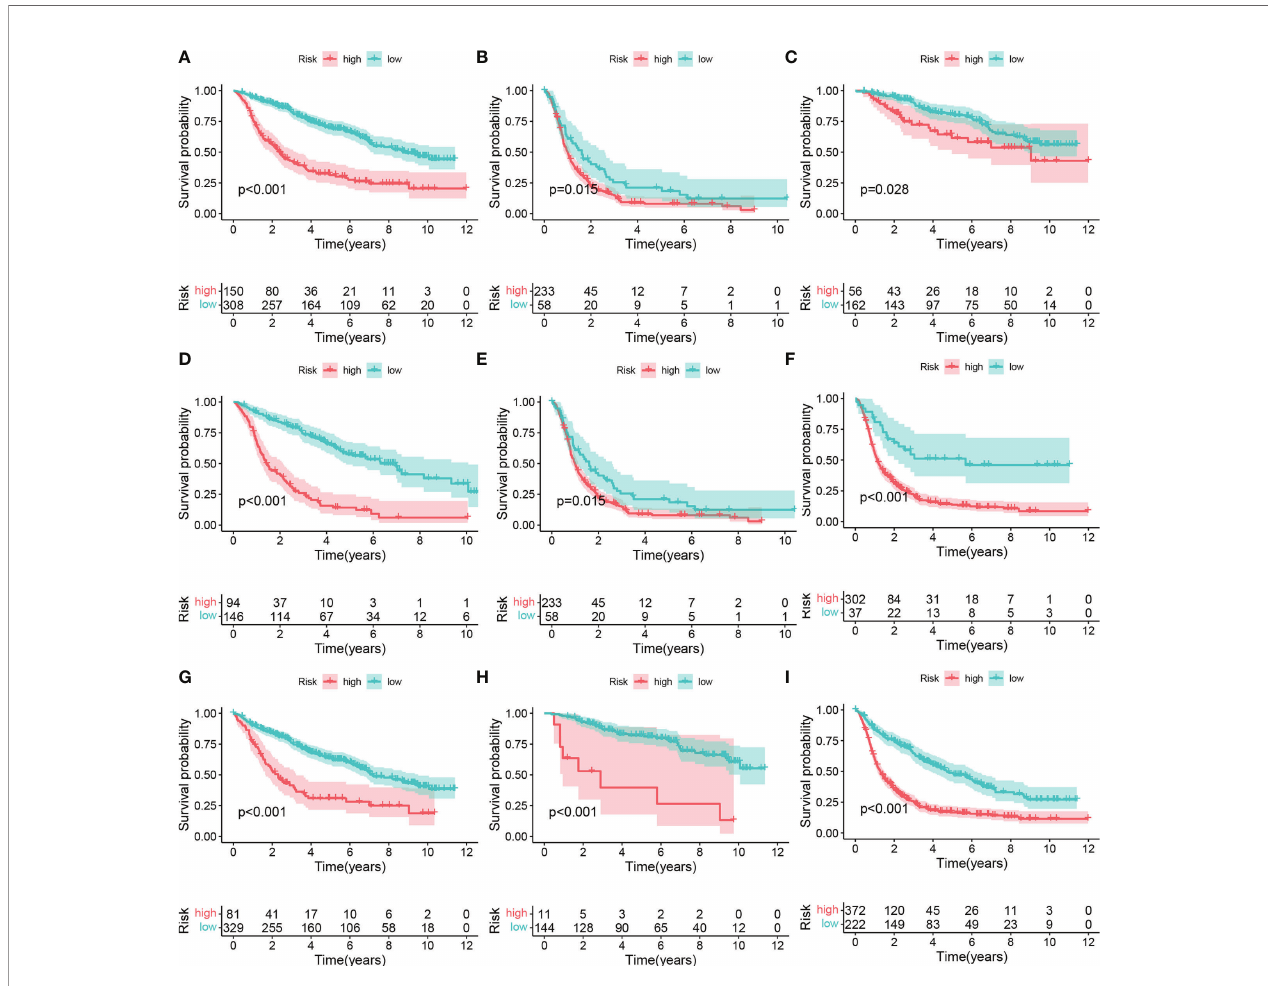
FIGURE 4 | Subgroup analysis of high- and low-risk group. (A) LGG, (B) GBM. (C) WHO II, (D) WHO III, (E) WHO: IV. (F) IDH wildtype, (G) IDH mutant, (H) 1p9ql codeletion, (I) 1p19ql